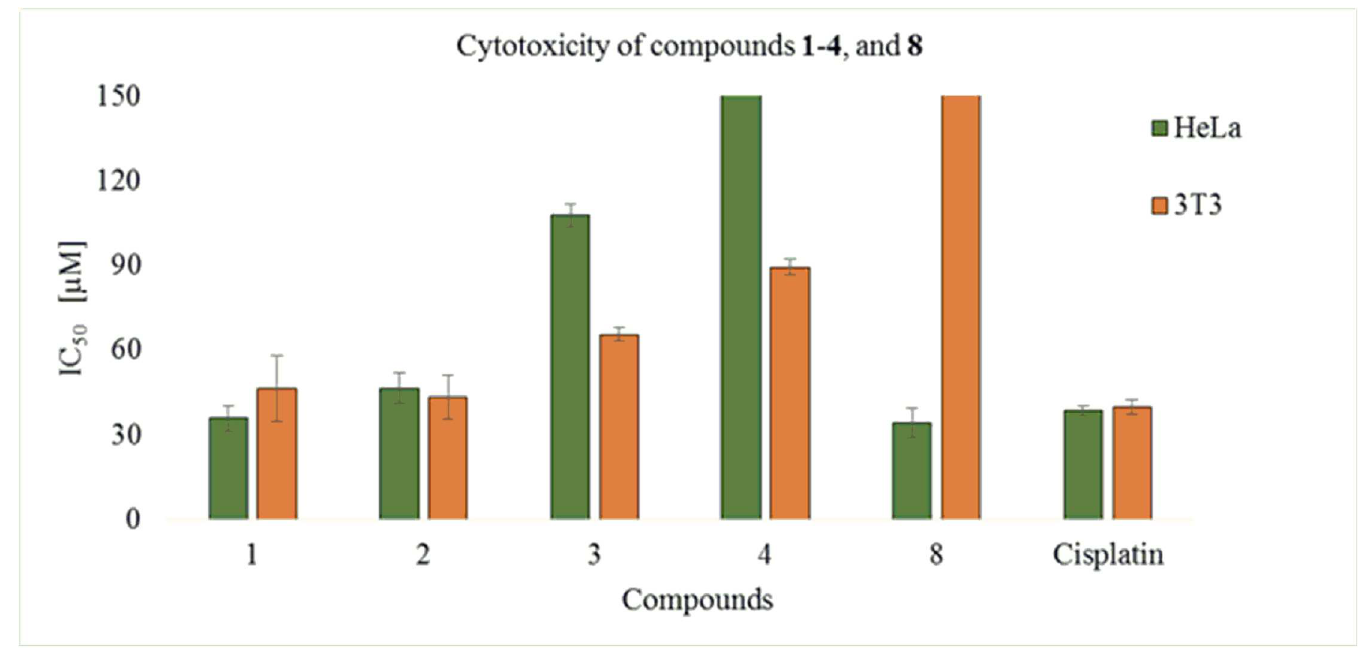
Fig 11. Cytotoxicity of compounds were shown in graphical representation.